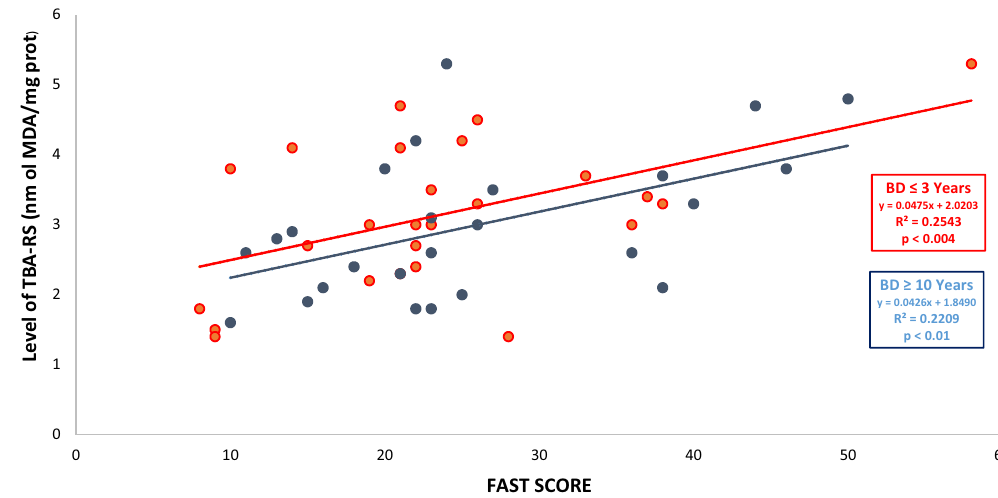
Figure 3. Correlation between Levels of TBA-RS and FAST test scores between BD patients ≤ 3 years (in red) and ≥ 10 years of the disease (in blue) using the Spearman correlation